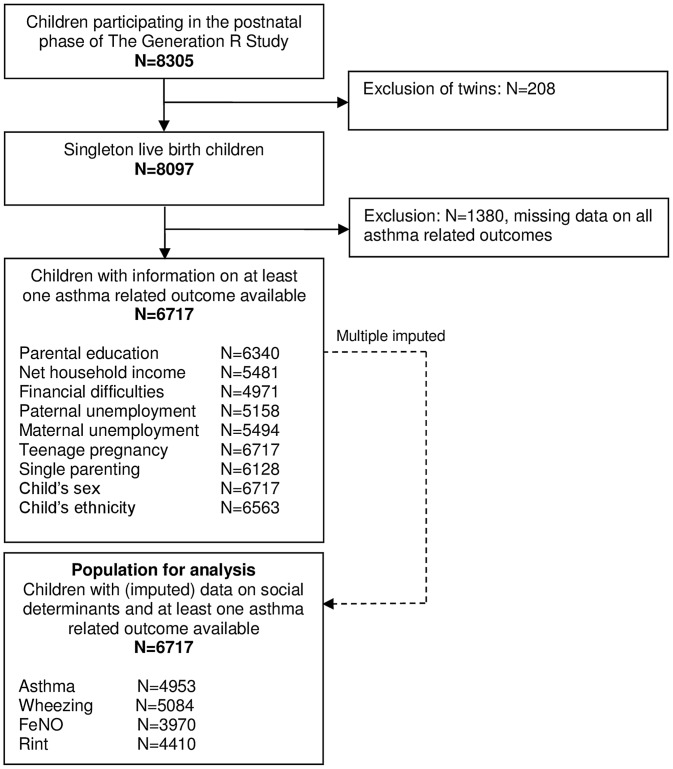
Flowchart of participants included for analysis.